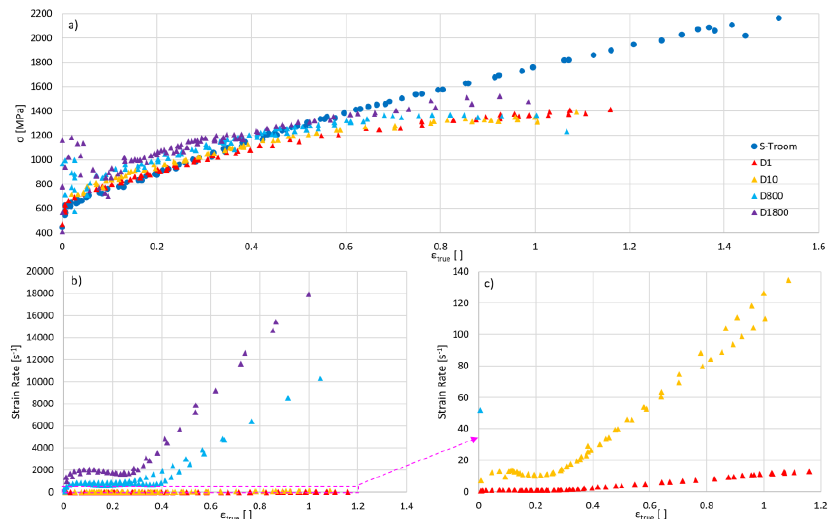
Fig. 2. Dynamic experiments at initial room temperature: (a) true stress-strain curves compared to the static curve at room temperature; (b) Strain rate vs strain curves and (c)